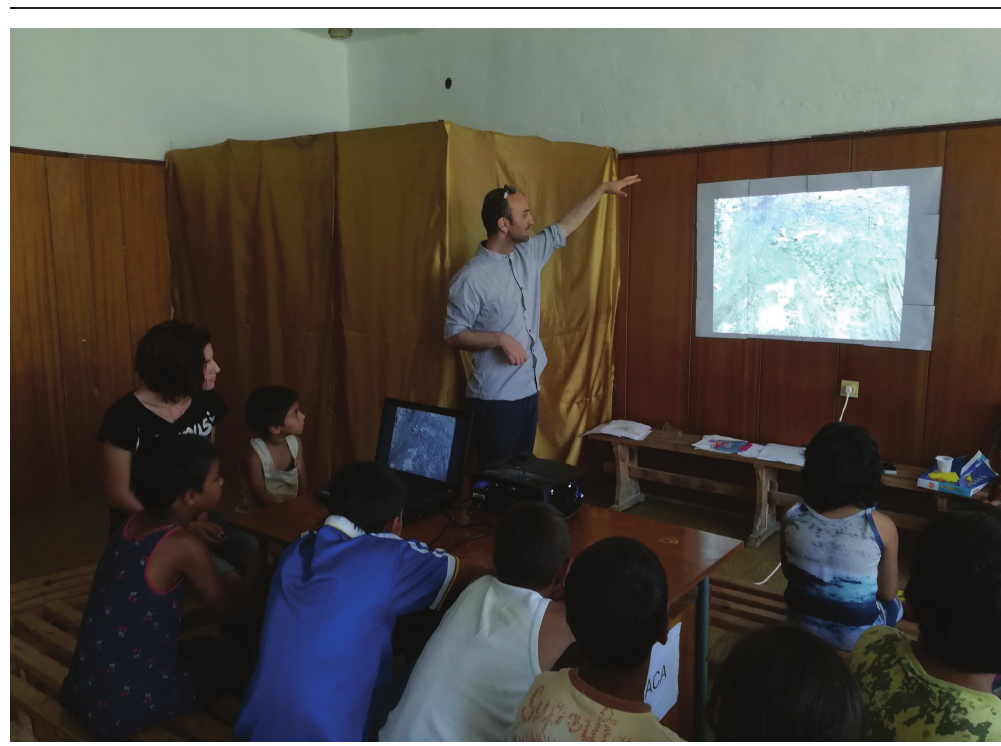
Figure 1: Screening of Back to School in the village of Belentsi